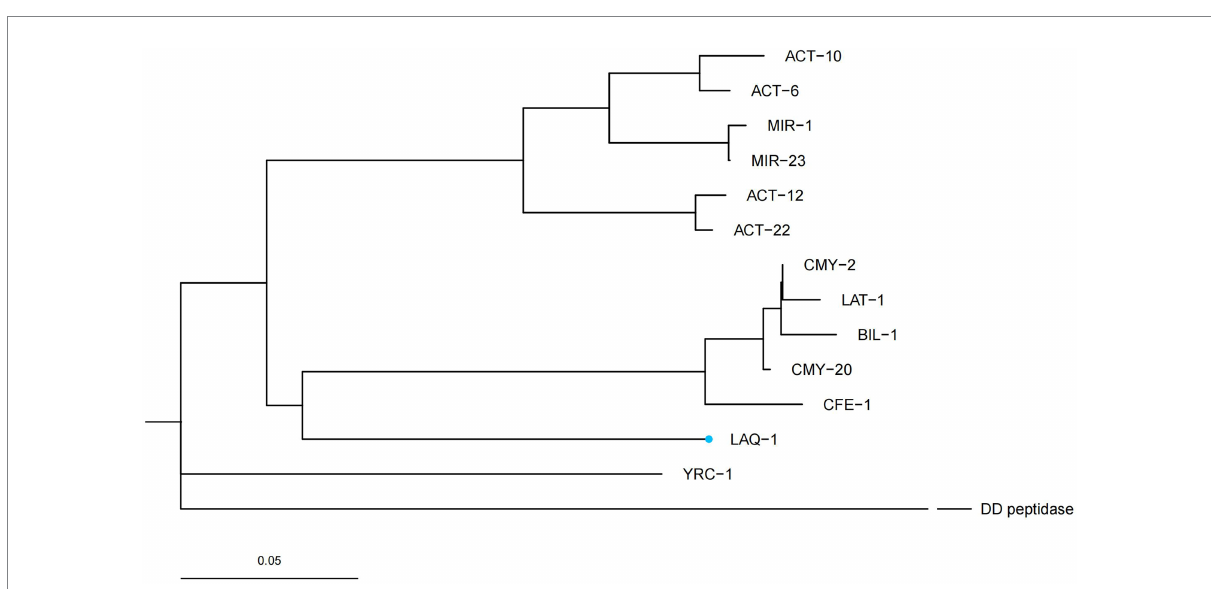
FIGURE 2 A rooted phylogenetic tree of LAQ-1 with its function-characterized relatives. DD peptidase of Streptomyces R61 (D-alanyl-d-alanine- Carboxypeptidase, 1CEF_A) was used as an out group. LAQ-1 from our study is shown with a blue dot. The other sequences and their accession numbers are ACT-12 (AFU25650.1), ACT-22 (AHM76774.1), BIL-1 (CAA52618.1), CMY-2 (CAA62957.1), CMY-20 (AAX58682.2), LAT-1 (CAA55007.1), CFE-1 (BAC76072.1), YRC-1 (ABA70720.1), MIR-1 (AAD22636.1), MIR-23 (AIG20028.1), ACT-6 (ACJ05686.1), ACT-10 (AEV91214.1).